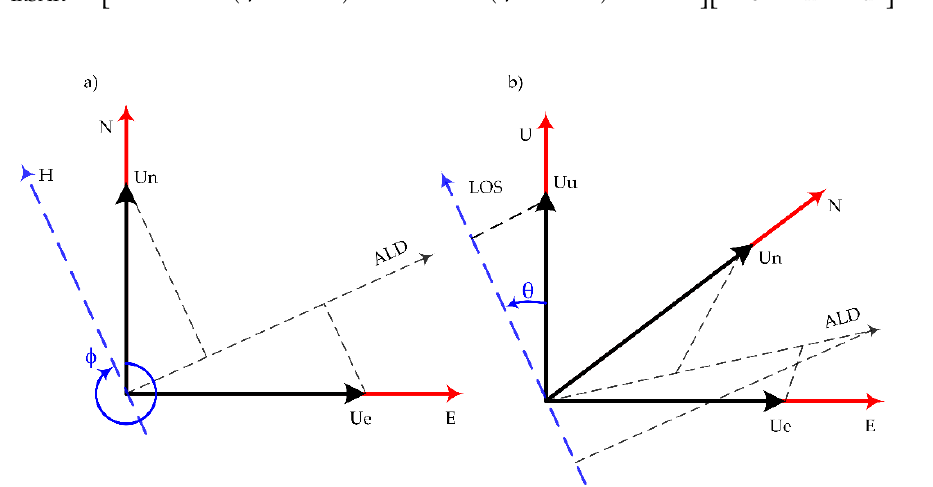
Figure 1. Sketch map of the relationship between interferometric synthetic aperture radar (InSAR) observation and surface displacements [41]. a) Top-view showing the North – South (N) and East – West (E) components projection on the azimuth look direction (ALD). b) 3D sketch of surface deformation components and InSAR observations.